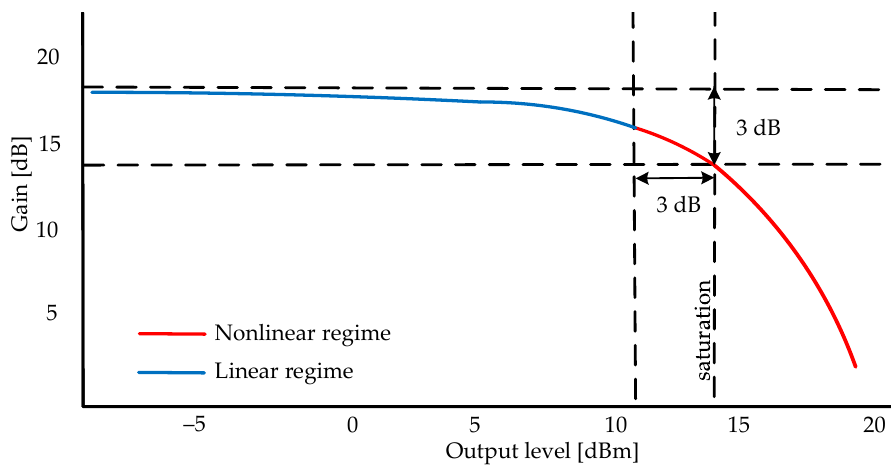
Figure 9. Gain dependence on the output